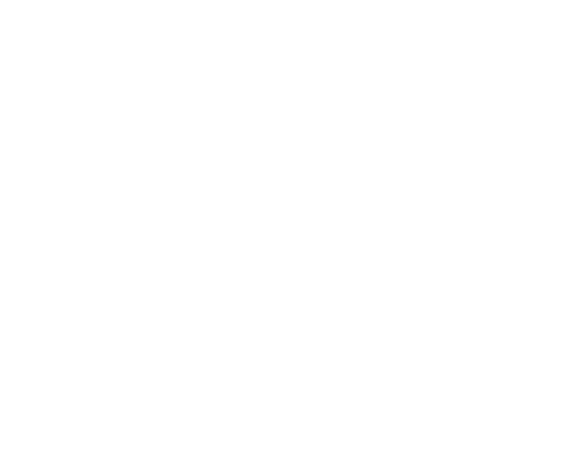
Figure 14. Treasure from Wiener Neustadt. Finger ring with “lily” motif, early 14th century. Photo: Paul Kolp; editing: Franz Siegmeth.